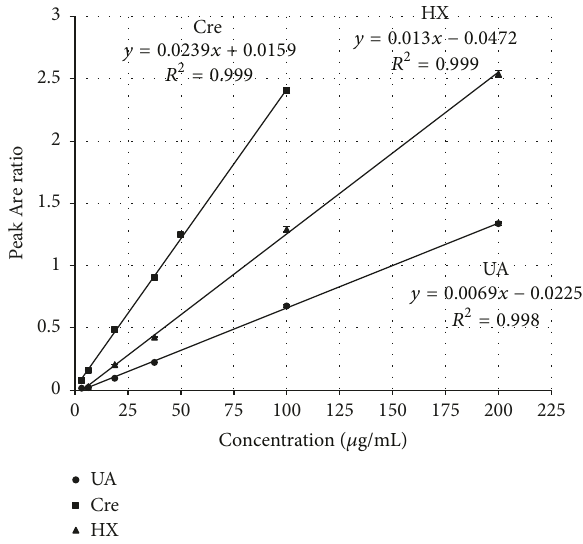
Figure2:Calibrationcurvesobtainedforuricacid(UA;3.12–200 𝜇 g/ mL), creatinine (Cre; 3.12–100 𝜇 g/mL), and hypoxanthine (HX; 6.25–200 𝜇 g/mL) ( 𝑛 = 5